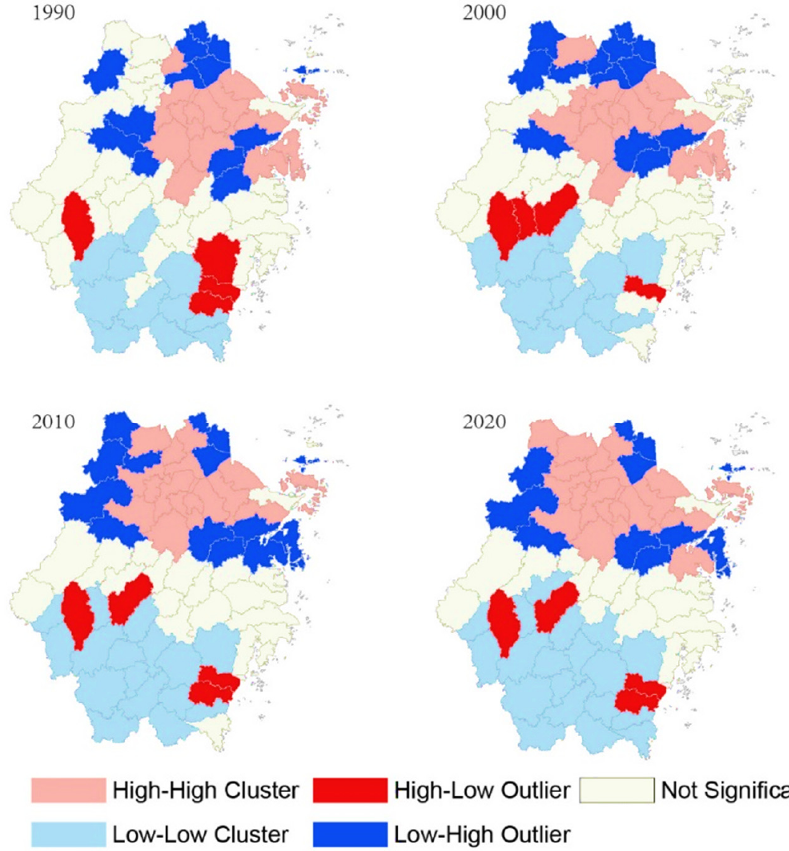
Figure 3. Mapping of local spatial autocorrelation of urban expansion from 1990 to 2020 ( p < 0.05). The “high-high cluster” areas of urban development were mainly concentrated in the northern region of Zhejiang province, comprising cities that included Hangzhou, Ningbo, Shaoxing, Jiaxing, and Huzhou. These areas have flat terrain and dense river networks. The high-high cluster region of Zhejiang province is one of the most economically developed areas in China and has continuously attracted a large populace due to the socio-economic development of cities within the region. In contrast, the “low-low cluster” areas were predominantly distributed in the central and southern parts of Zhejiang, comprising cities that included Quzhou, Lishui, and some parts of Wenzhou and Jinhua. These regions are in mountainous areas, having a short supply of urban land use, i.e., inadequate land resources for urban development. A “high-low outlier” was observed in the southern region of the study area’s central urban fabric. This included cities such as Quzhou, Wenzhou, and Jinhua. Compared with other counties under the jurisdiction of these cities, these central urban areas, i.e., the high-low outliers, represented the local political, economic, and cultural hub, which gathered a lot of resources and exhibited a peak during the depression. The results also showed a “low-high outlier”, observed in areas such as the west of Hangzhou, the west of Huzhou, the south of Ningbo, and areas of smaller scale. Such regions have numerous mountains, which means these areas are not suitable for large-scale urban